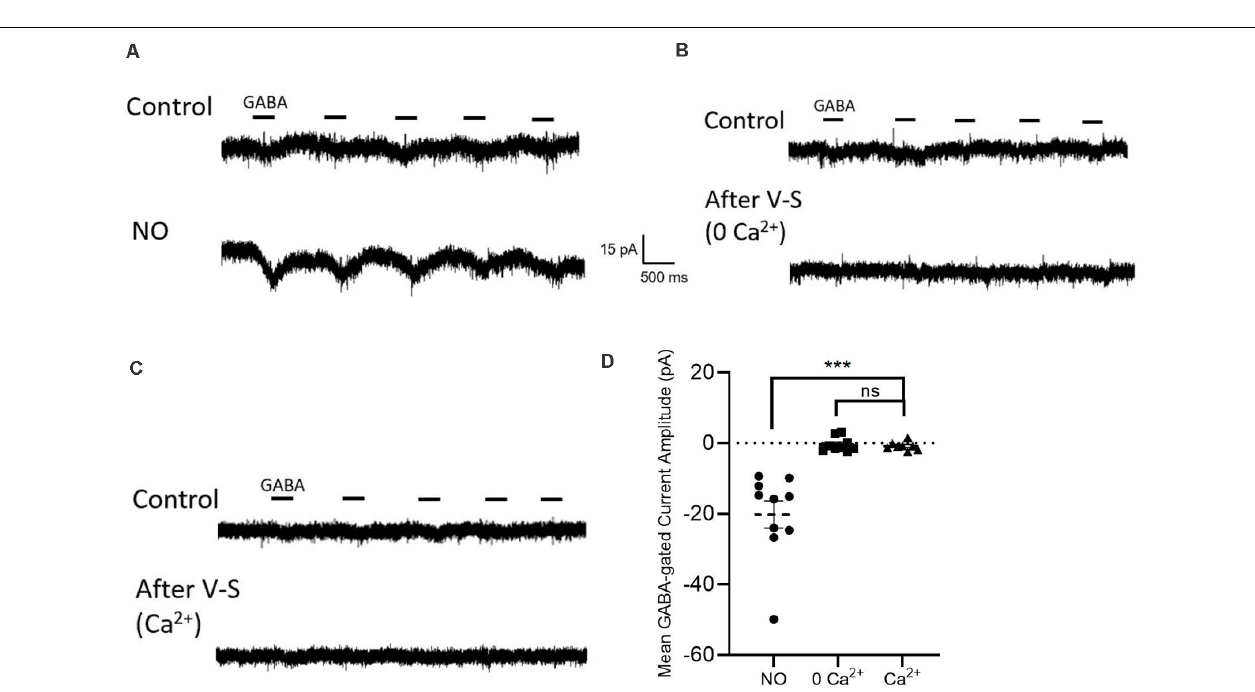
FIGURE 6 | Influx of external Ca 2+ fails to release Cl − from the internal store. (A) Sample traces from cells are held at − 70 mV with GABA (20 µ M) applied for 400 ms. With NO stimulation, GABA-gated inward currents generate. (B) Voltage-step control settings in zero Ca 2+ zero Cl − external environment. Sample traces from cells that the top trace is stimulated with GABA pulse protocol, the bottom trace is repeated with GABA pulse protocol after voltage step stimulation. (C) Same experiment setting in Ca 2+ (3 mM) external solution. (D) The quantified mean GABA-gated current amplitude ± SEM; NO control, n = 10; 0 Ca 2+ control, n = 9; Ca 2+ , n = 8; p = 0.6; ns: not significant. *** P < 0.001 (repeated-measures ANOVA).